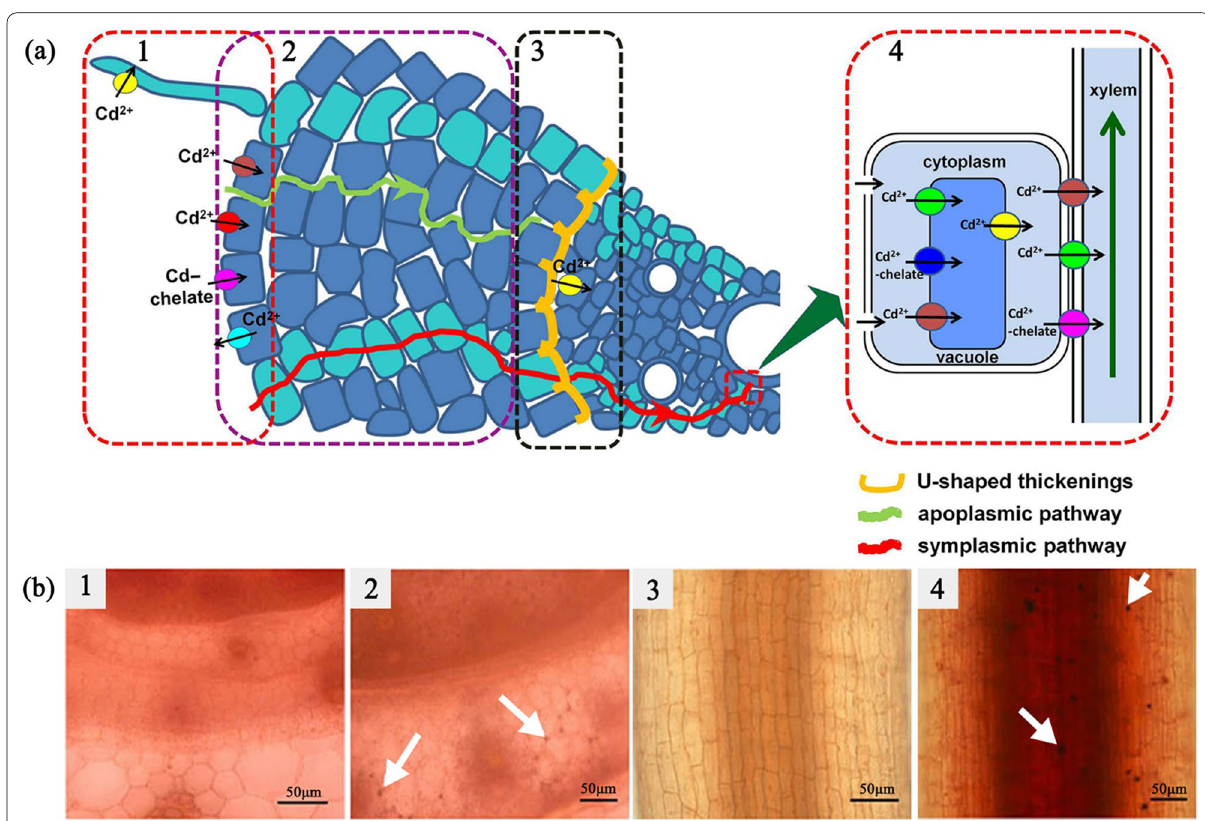
Fig. 3 The mechanisms of Cd accumulation in sweet sorghum plants and the localization of Cd in different tissues. a The main physiological processes involved in Cd uptake and translocation: 1, uptake of Cd from the external solution to root cells; 2, cell wall binding of Cd; 3, apoplastic barriers in the endodermis; 4, Cd translocation via xylem. Adapted from [67], John Wiley & Sons, Inc. Copyright (2017). b Cd‑dithizone precipitates in caulicle (1, 2) and root (3, 4). Sweet sorghum seedlings were exposed to 0 (1, 3) or 100 μM (2, 4) Cd concentration for 3 weeks. Adapted by permission from [64]. Springer Nature, Copyright